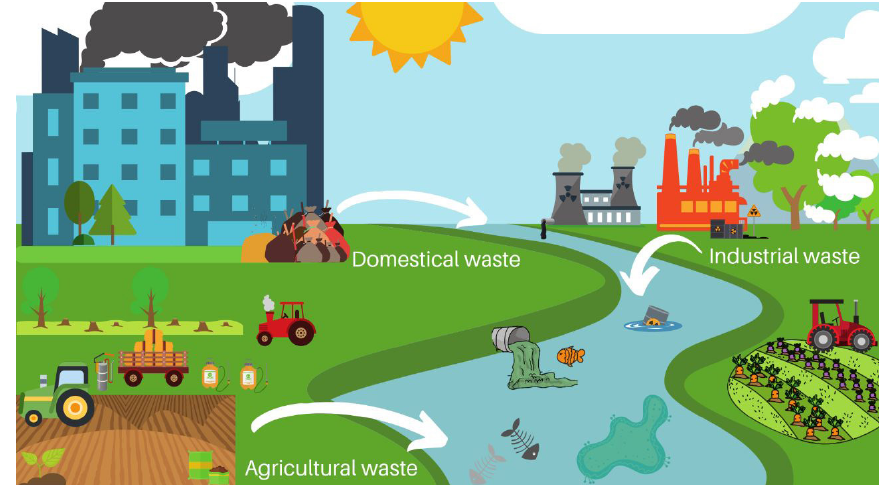
Figure 2. Different sources of chemicals to aquatic